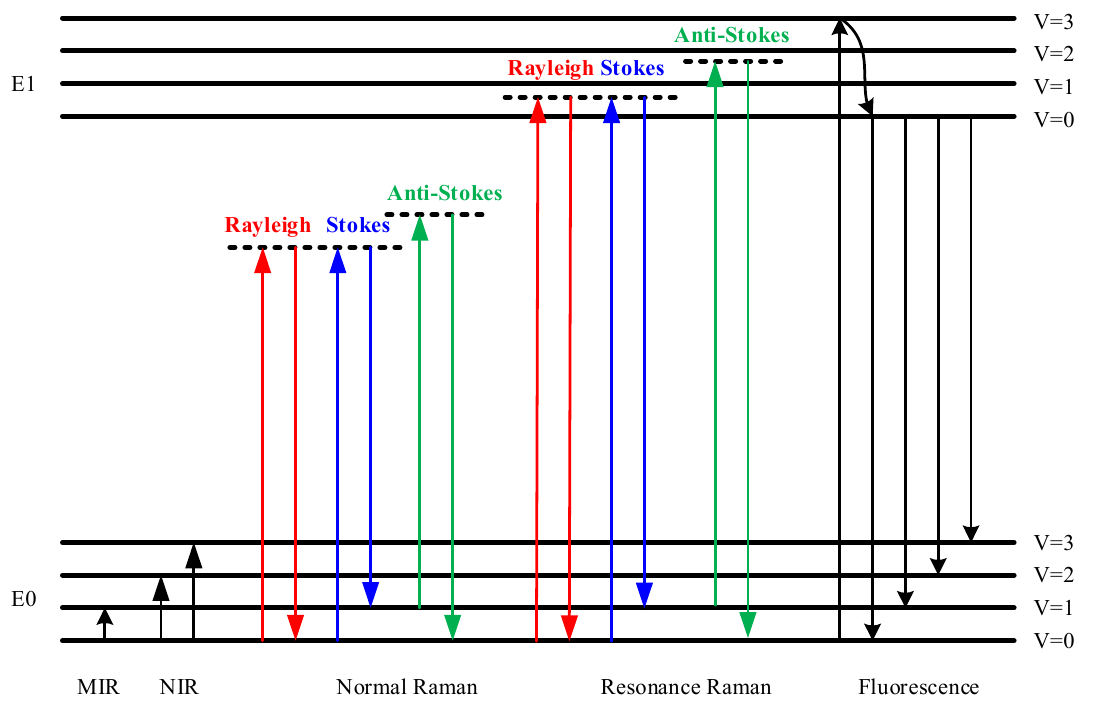
Figure 1. Energy level diagram related to IR absorption, Raman scattering and fluorescence